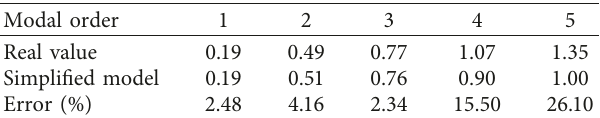
Table 11: Comparison of the first five natural frequencies between the prototype model and the equivalent